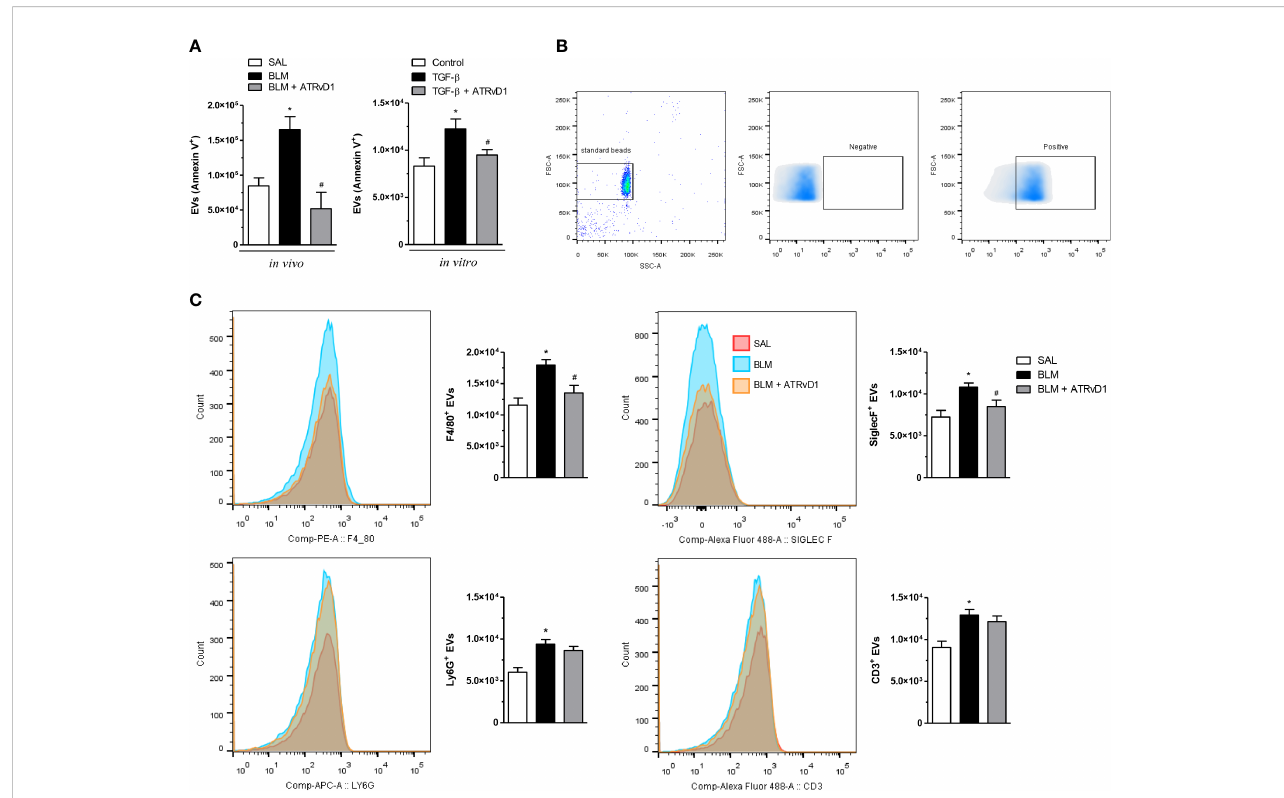
FIGURE 4 ATRvD1 inhibits the release of extracellular vesicles (EVs) in vivo and in vitro . (A) EVs were isolated from the BAL obtained on day 14 after the SAL, BLM, and BLM + ATRvD1 treatments or from the conditioned medium harvested 24 h after the macrophages were incubated with TGF- b (10 ng/ml) or TGF- b + ATRvD1 (100 ng/ml). The EVs were stained for FITC-labeled annexin V and analyzed by fl ow cytometry. (B) Dot-plots and density-plot images show the gate strategy for EVs: (i) the gate region of large vesicles using 1- m m standard beads (left); (ii, iii) gates were de fi ned from unlabeled vesicles (negative), being considered positive for the speci fi c markers of the fl uorescence captured following that point. (C) The EVs obtained from BAL were also stained for F4/80-PE (macrophages), SinglecF-alexa488 (eosinophils), Ly6G-APC (neutrophils), and CD3-alexa488 (lymphocytes) and analyzed by fl ow cytometry, and fl uorescence was plotted as histogram and bar graphs of absolute number. Results represent mean + SEM from three independent experiments. * P ≤ 0.05 vs. the SAL/control; # P ≤ 0.05 vs. the treated groups (BLM or TGF- b